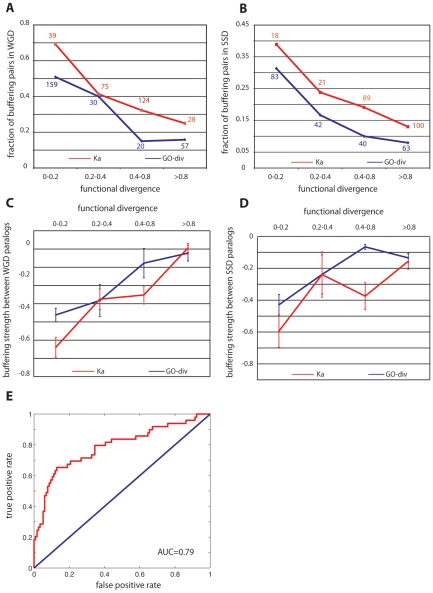
Genetic buffering between gene duplicates results from functional redundancy.(A) and (B) indicate functionally similar genes are more likely to backup each other for WGD (A) and SSD (B) paralogs, respectively, where functional divergence was calibrated by the overlap of GO annotations (GO-div) and coding sequence divergence (Ka). The number of total pairs in each bin is indicated for GO-div and Ka. (C) and (D) indicate buffering strength between paralogs is on average proportional to their functional similarity for WGD (C) and SSD (D) paralogs, respectively. (E) is the receiver operating characteristic (ROC) curve for the prediction of backup capacity between paralogs based on functional similarities. This curve, together with the AUC (area under the curve) score, was from one random realization of the 3-fold cross-validation.